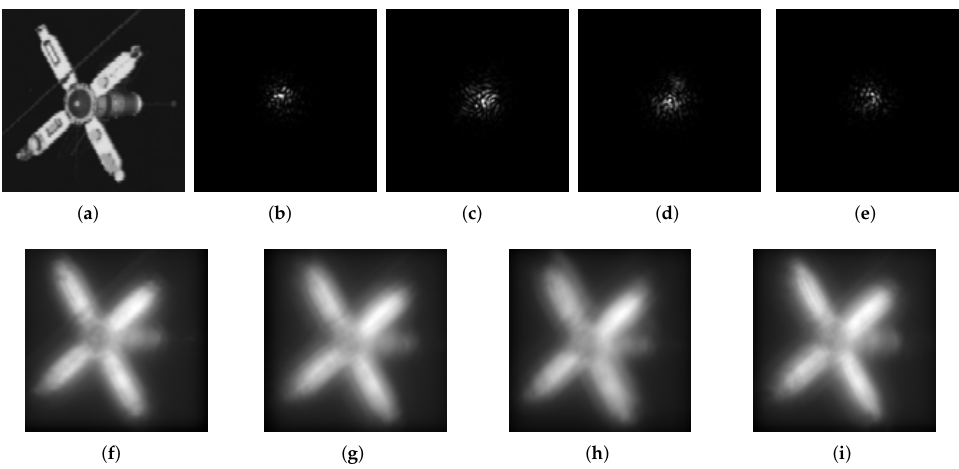
Figure 3. The image is degraded by the point spread function. ( a ) is the original image. Resolution is 128 128. Point Spread Functions are shown in ( b – e ). Degraded images corresponding to the ( b – e ) are shown in ( f – i ).